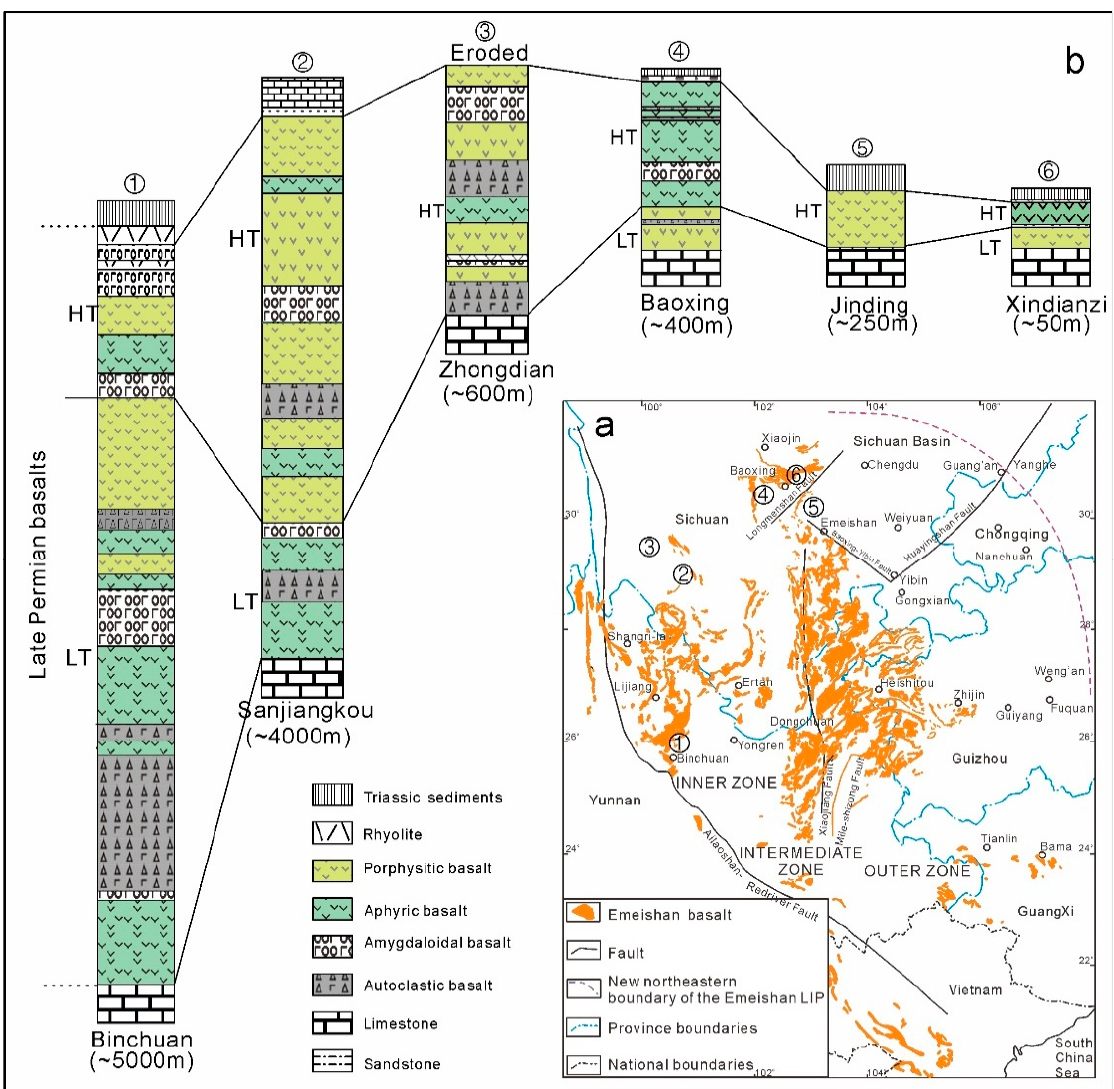
Figure 13. ( a ) Geological sketch map showing the area of the ELIP [60]. ( b ) Representative strati ‐ graphic columns of Emeishan basalts [15,25,28,40,42,44,60,81].